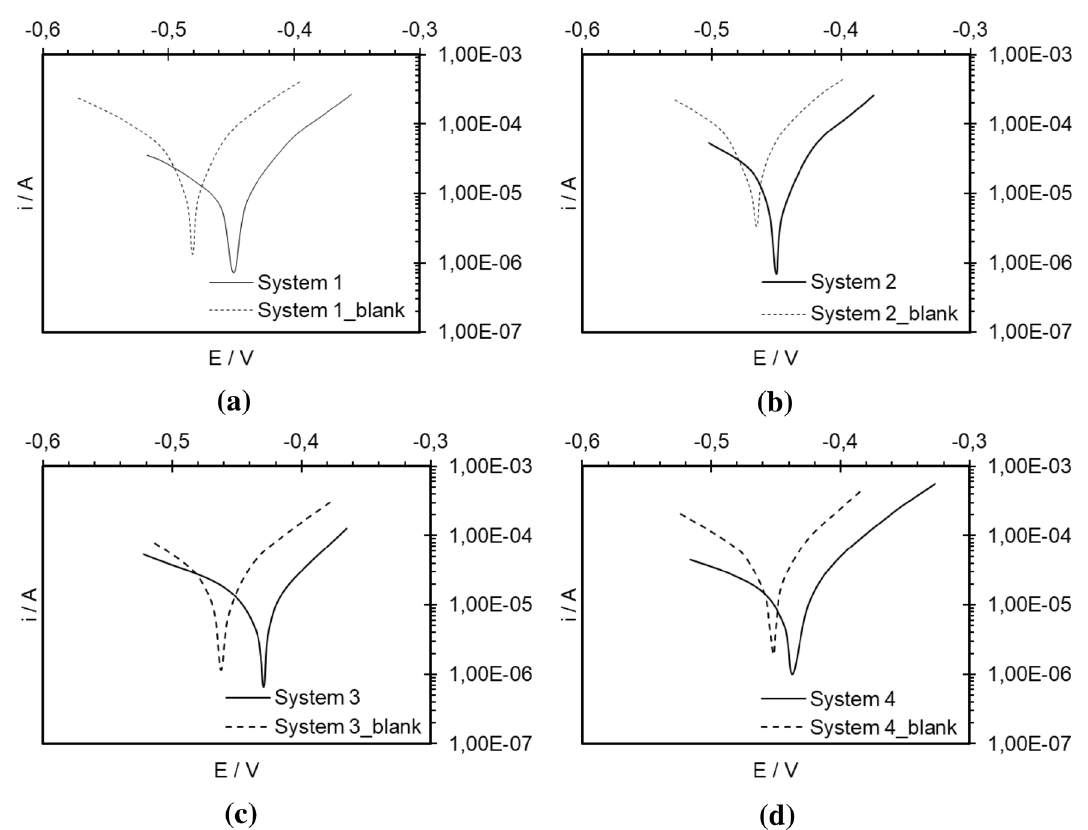
Fig. 4 Potential–kinetic polarization curves for carbon-steel in the presence of aqueous and microemulsified media with HCl in concentrations of: a 1.5%, b 5%, c 10%, and d 15%